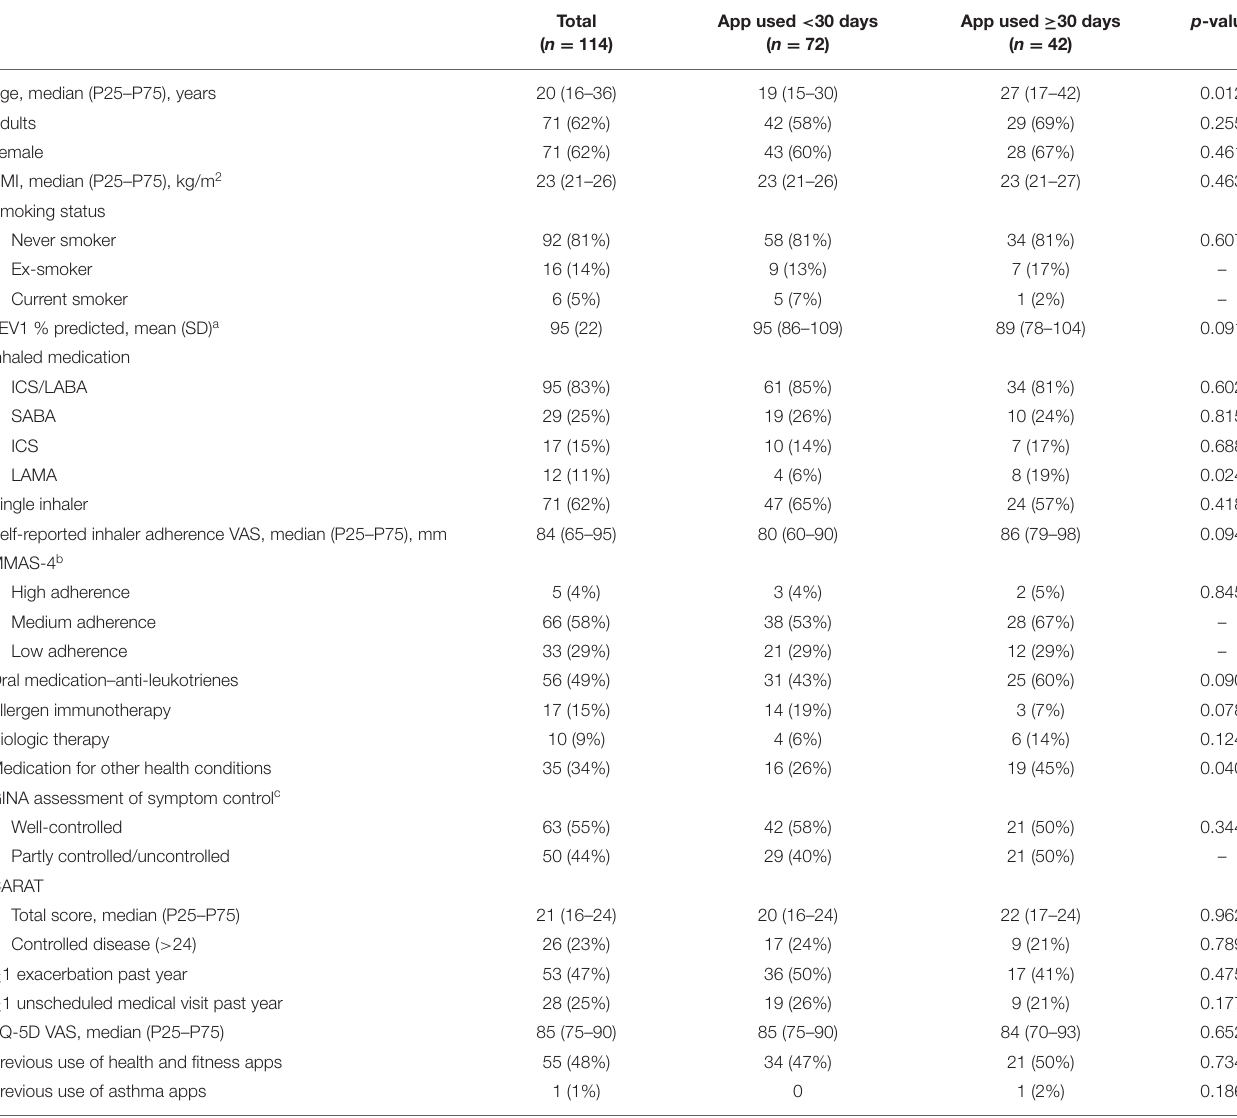
TABLE 1 | The baseline characteristics of participants ( n = 114).